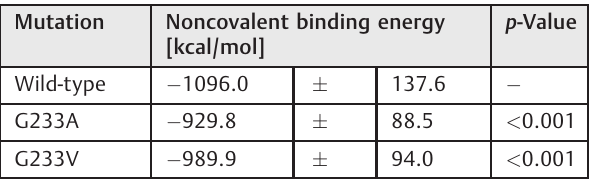
Table 1 Noncovalent binding energy generated between VWF and GPIb ɑ in wild-type and three of the mutants